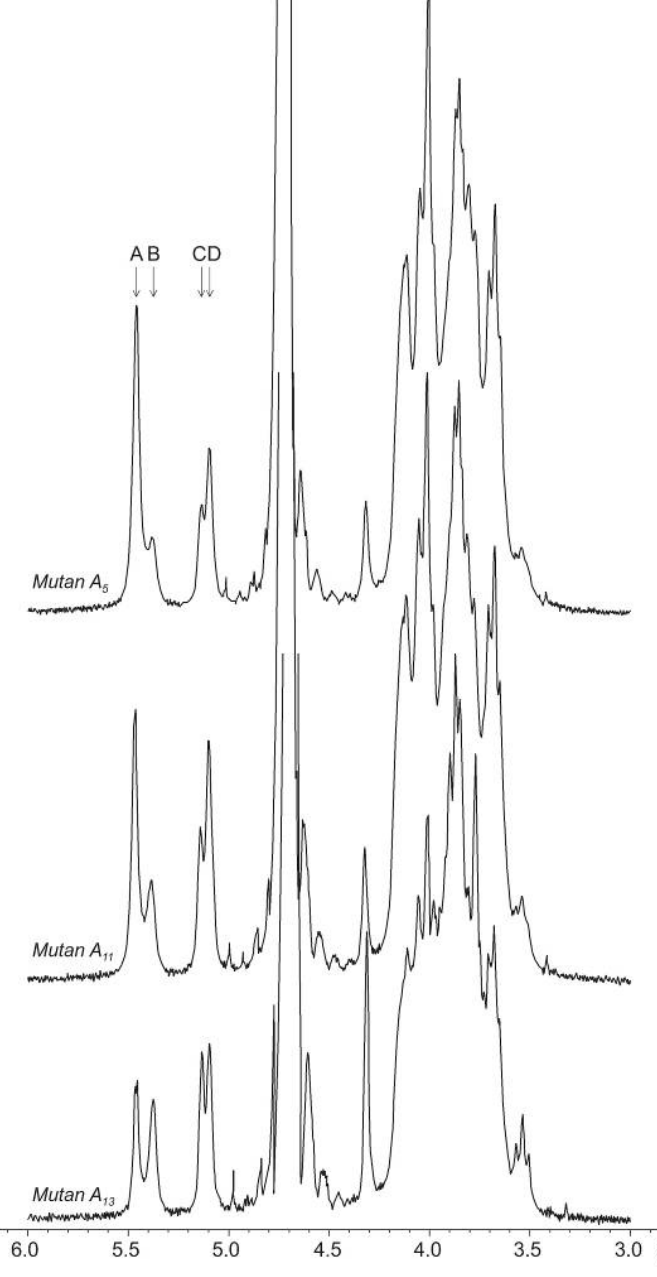
Figure 1. 1 H-NMR spectra of selected streptococcal mutans. Anomeric signals of: ( A ) α -(1 → 3)-linked glucose; ( B ) α -(1 → 3)-linked glucose substituted at O -6; ( C ) α -(1 → 6)-linked glucose substituted at O -3; ( D ) α -(1 → 6)-linked glucose. Samples were dissolved in 30% NaOD in D O and spectra were recorded at 300 MHz at 60 2